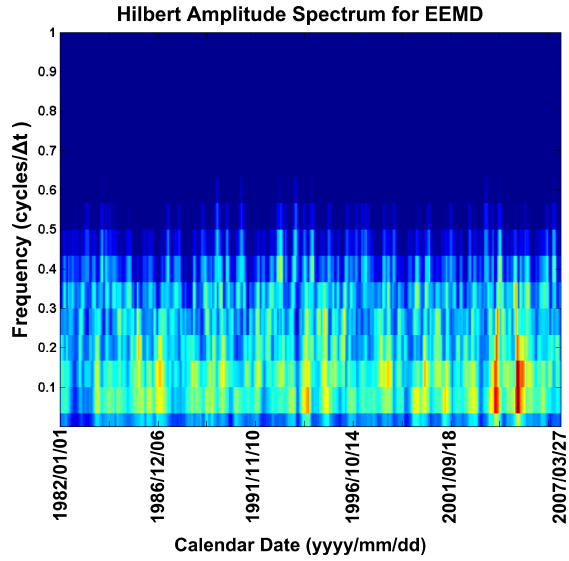
Figure 4. Hilbert–Huang amplitude spectrum of the intrinsic func-